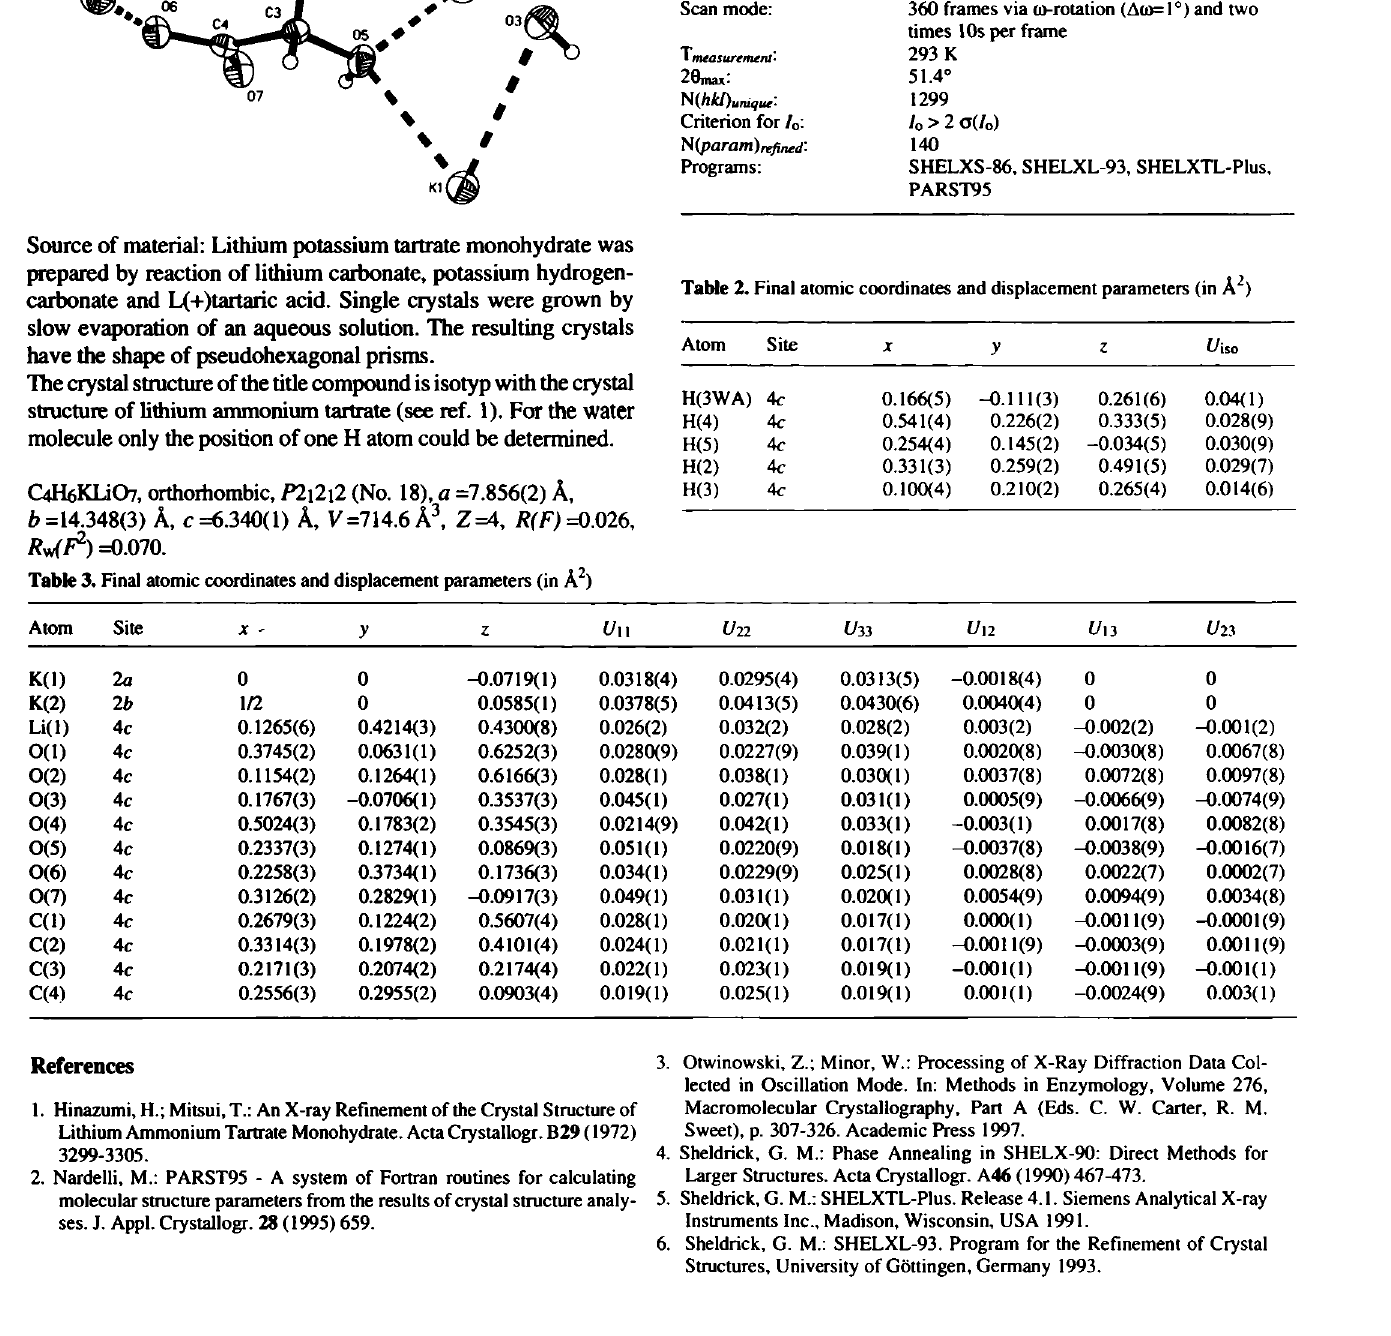
Table 1. Parameters used for the X-ray data collection Crystal: